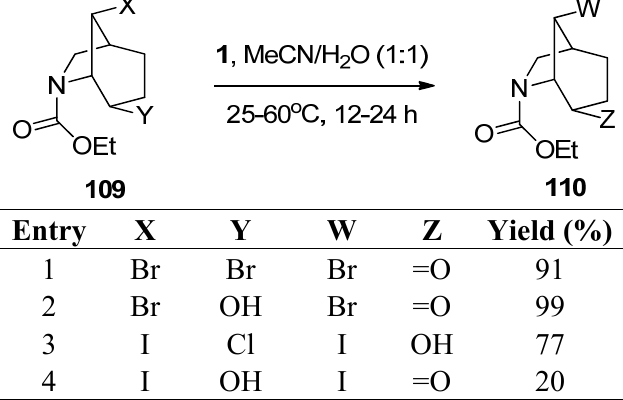
Table 7. F-TEDA-BF as a nucleofuge and oxidant of β 4